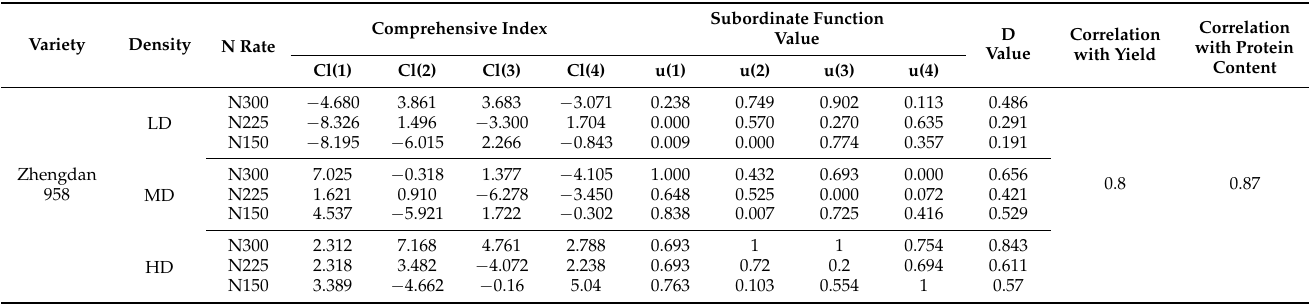
Table 3. Eigenvalue and contribution of each comprehensive index.